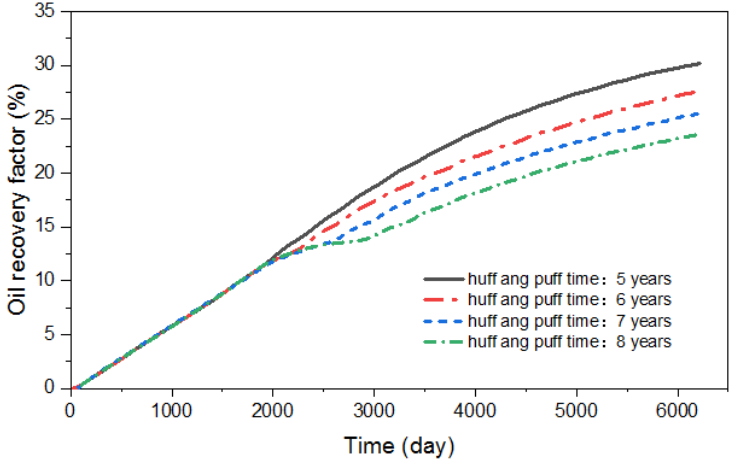
Figure 12. Variation of oil recoveries under different huff-n-puff timings.